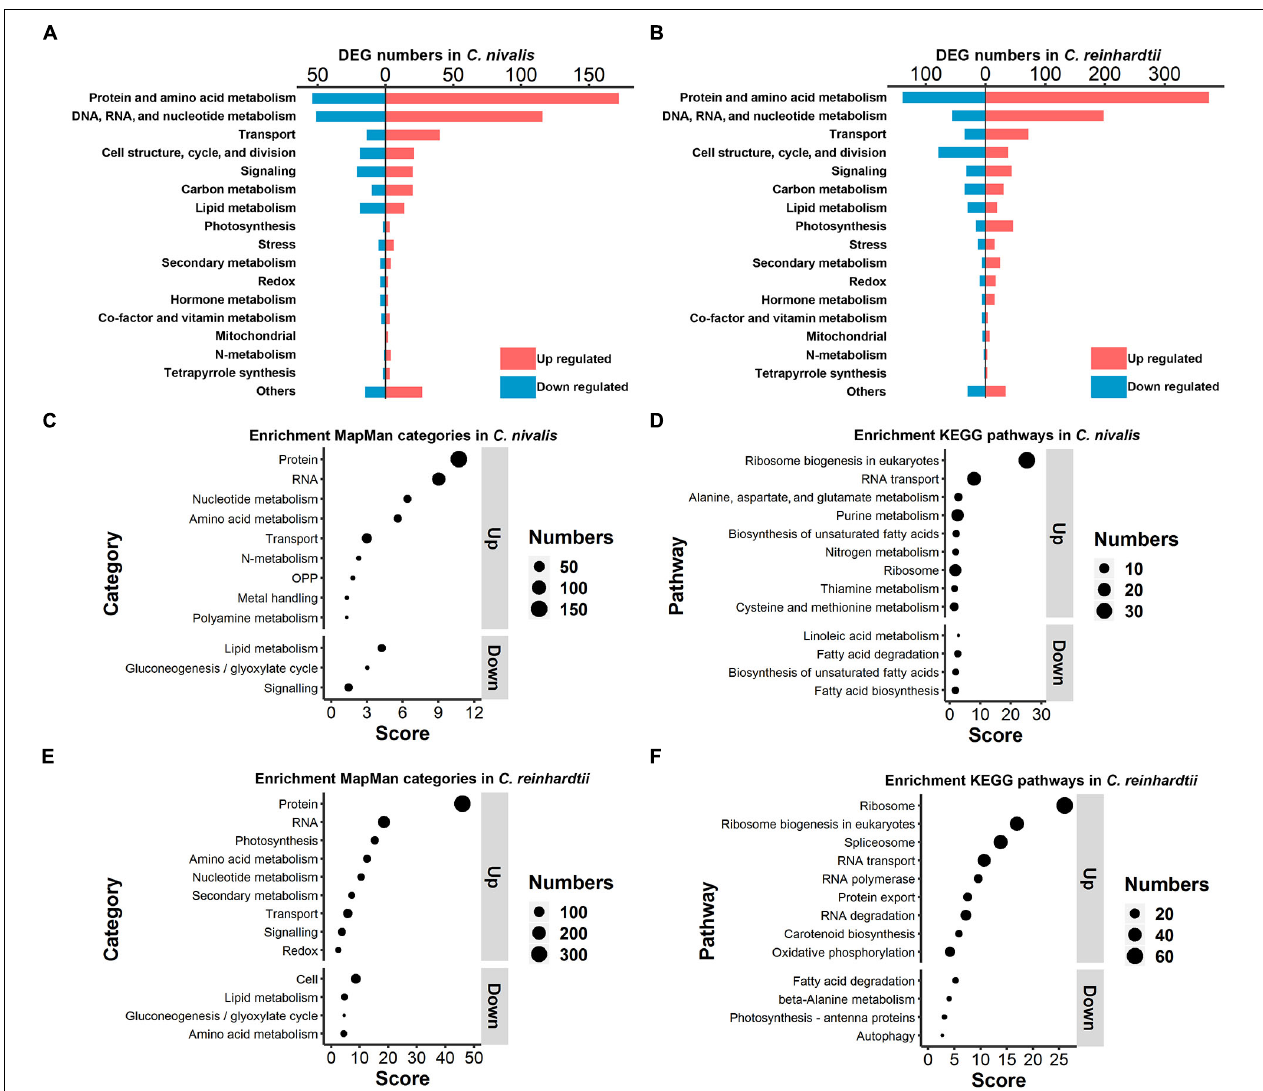
FIGURE 5 | Functional classification and enrichment analysis of DEGs in C. nivalis and C. reinhardtii. (A,B) Numbers of C. nivalis DEGs (A) and C. reinhardtii DEGs (B) in MapMan categories. For each category, upregulated and downregulated genes are indicated by color. (C–F) The bubble plots of enriched MapMan categories (C) and enriched KEGG pathways (D) in C. nivalis ; enriched MapMan categories (E) and enriched KEGG pathways (F) in C. reinhardtii. Only categories with scores > 1.3 are listed, separated as up or downregulated genes. Score for each category was calculated using the P -value (Score = –log 10 [ P -value]) in enrichment analysis. OPP, the oxidative pentose phosphate